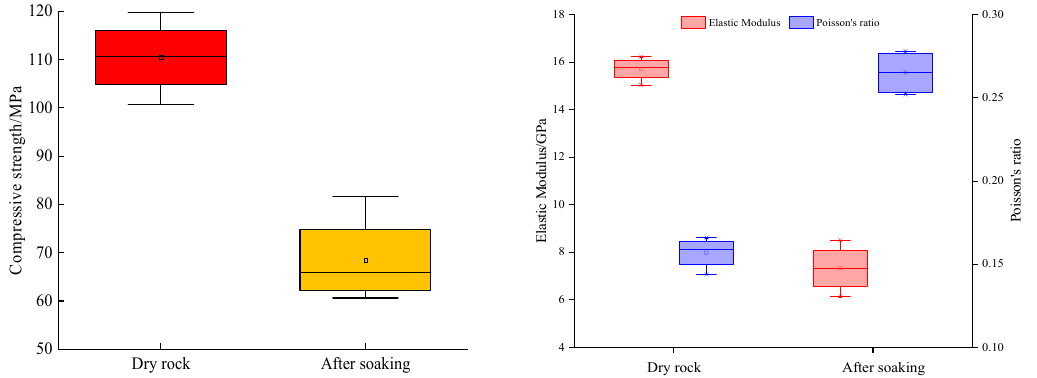
Figure 1. Changes in rock mechanical parameters before and after soaking (compressive strength on the left, and elastic modulus and Poisson’s ratio on the right).